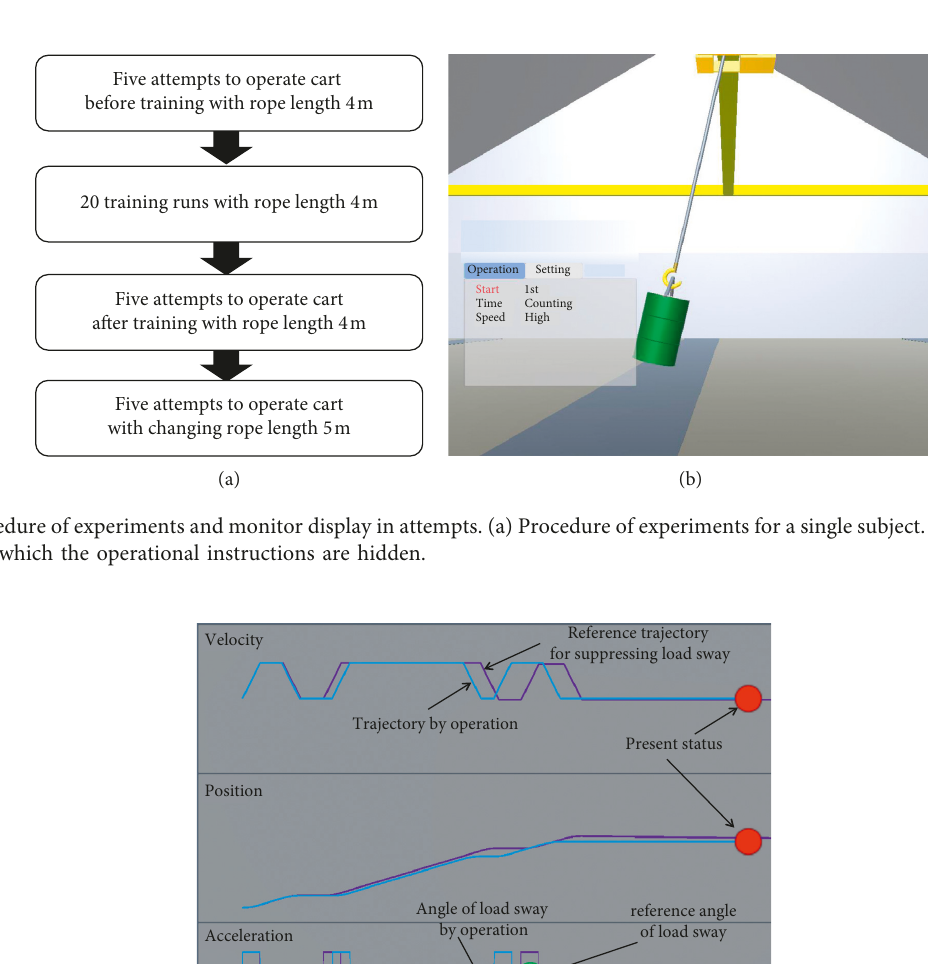
Figure 7: Monitor display of sway angles in overhead traveling crane